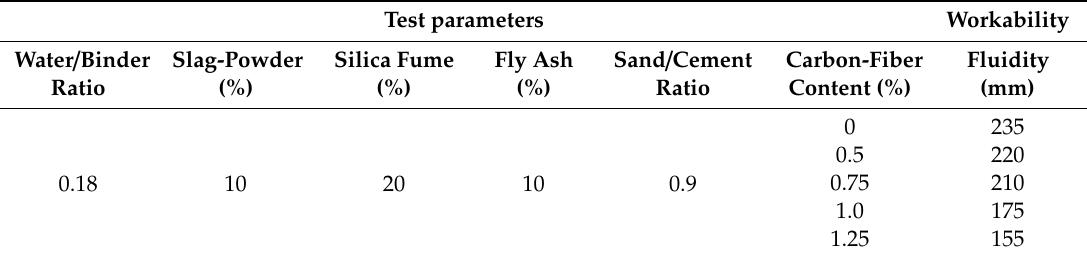
Table 7. RPC working